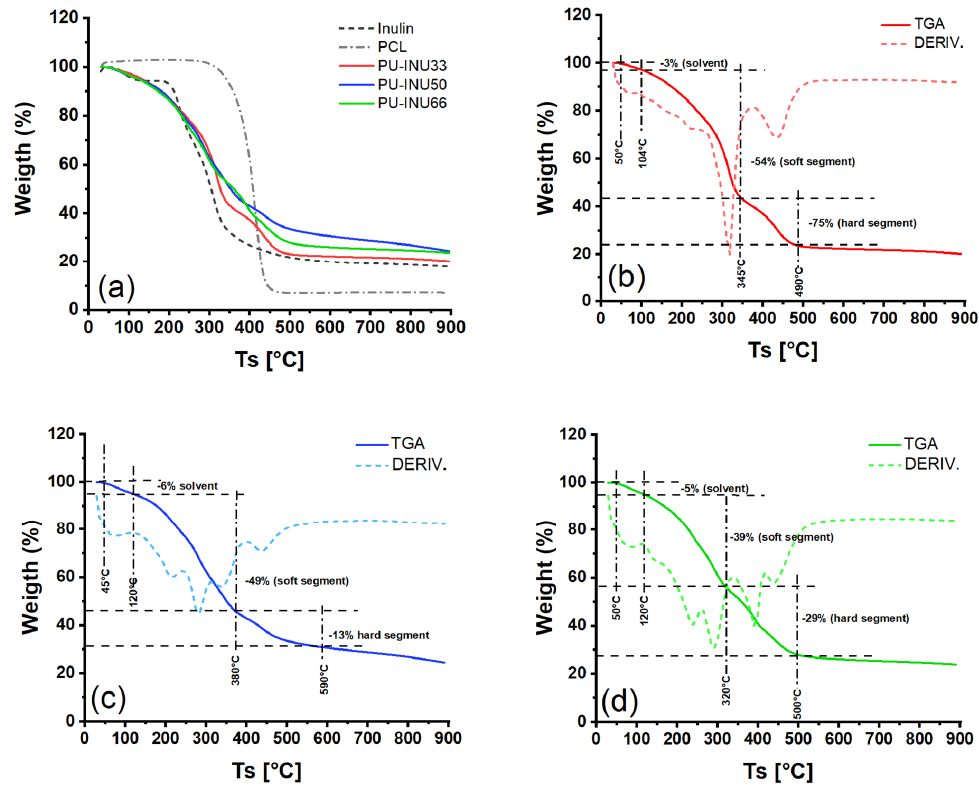
Figure 4. ( a ) Thermogravimetric analysis of polyol precursors (inulin and PCL) and synthesized PU–INU. Thermogravimetric analysis and its derivative (DTG) of ( b ) PU–INU33, ( c )